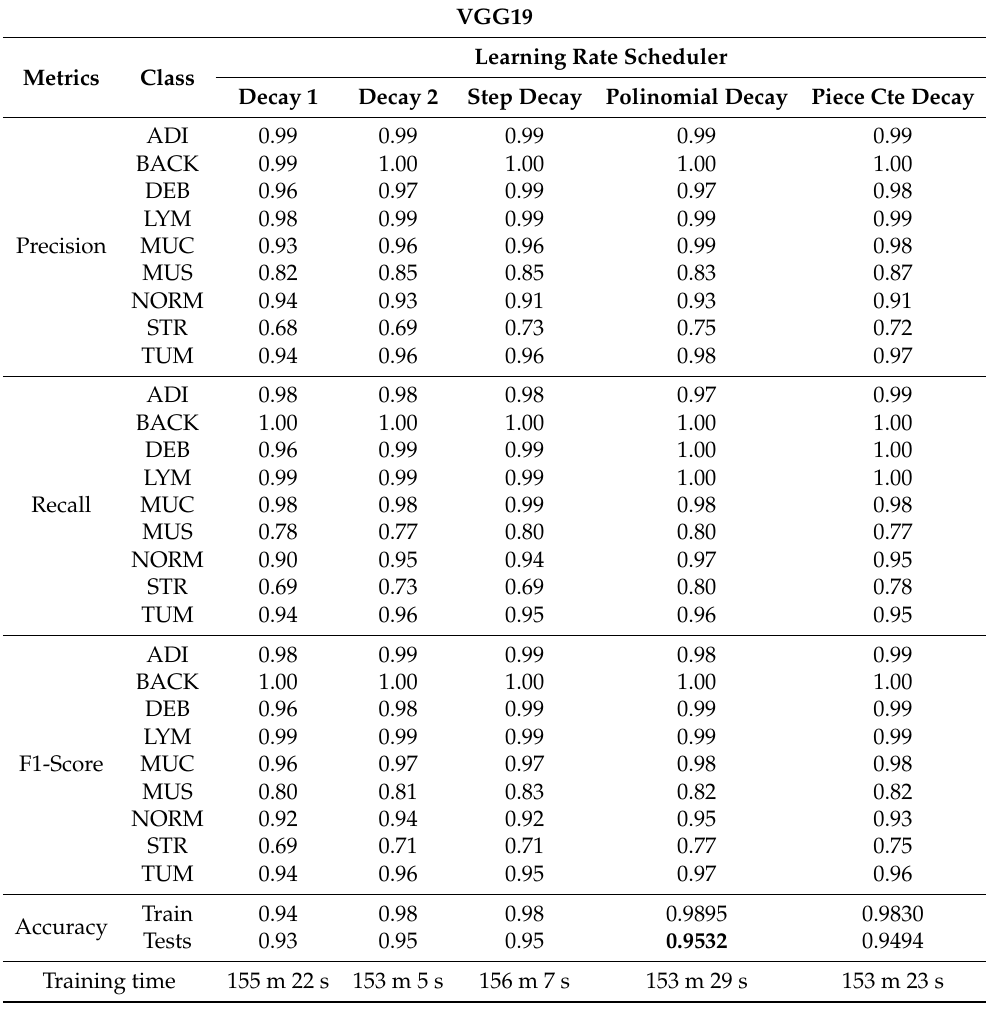
Table 4. The impact of using different methods of scheduler variation of the LR with respect to epochs on the training and validation of our model VGG19 Learning Rate Scheduler Metrics Class Decay 1 Decay 2 Step Decay Polinomial Decay Piece Cte